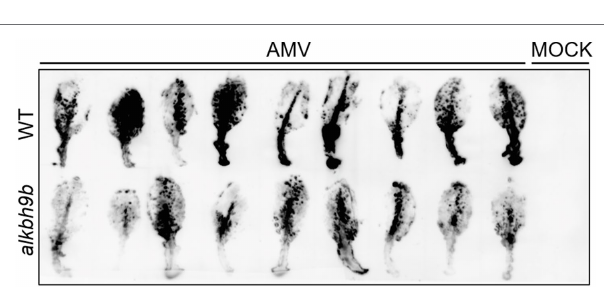
FIGURE 4 | AMV infection is impaired in inoculated leaves of alkbh9b plants. Tissue printing of inoculated leaves from WT and alkbh9b plants at 4 dpi. Nine biological replicates of each genotype are